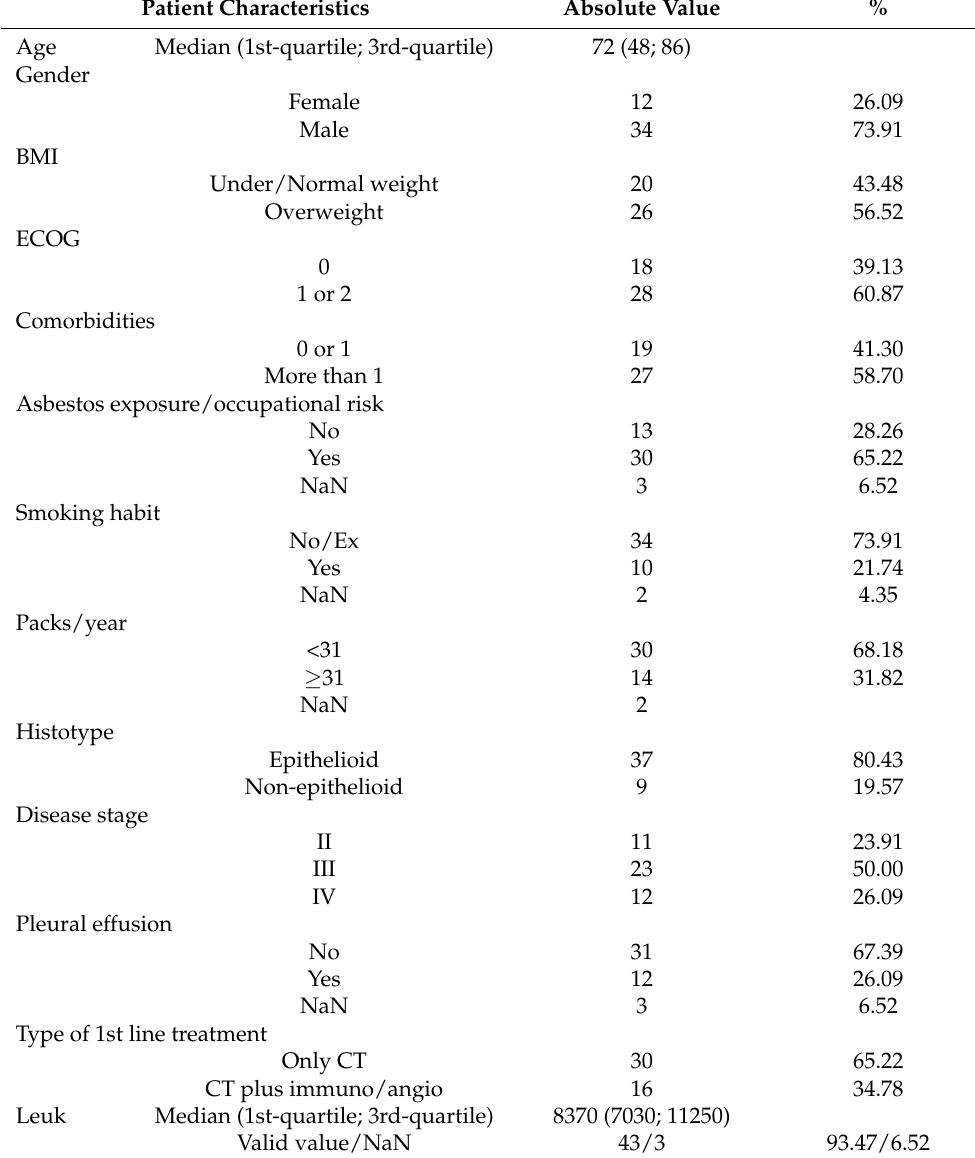
Table 1. Characteristics of the 46 patients analyzed in the study. Patient